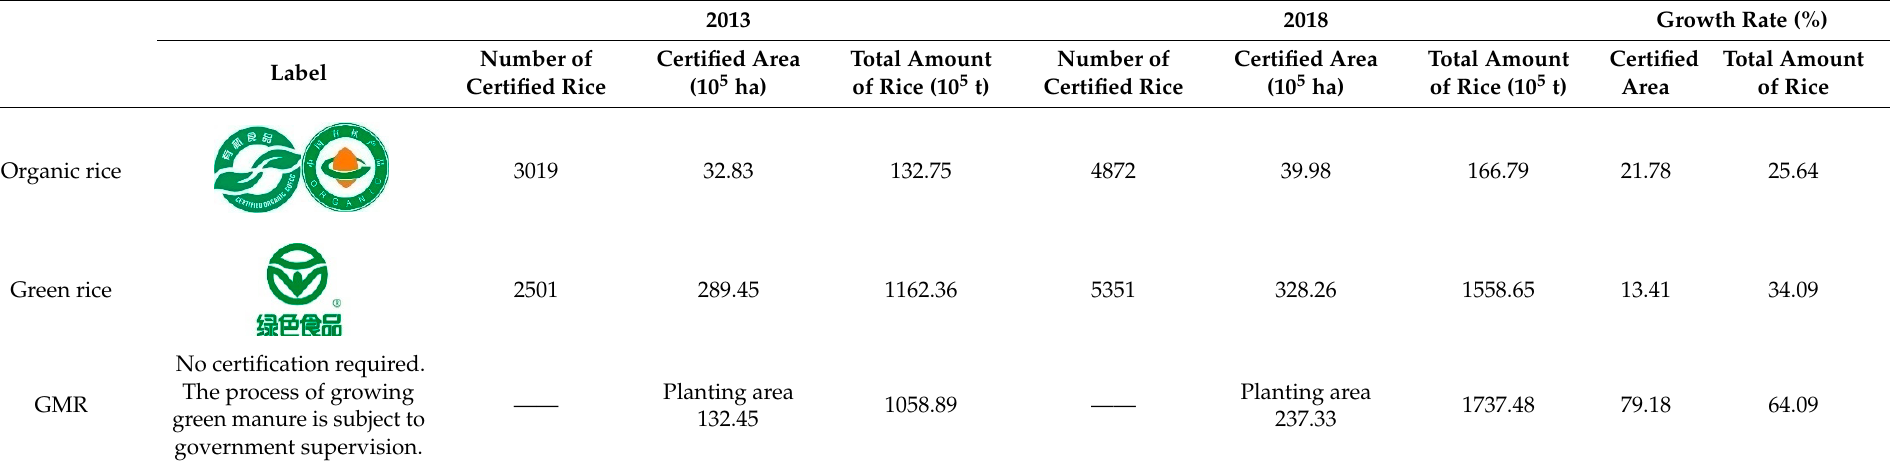
Table 1. Comparison of GMR with green rice and organic rice.